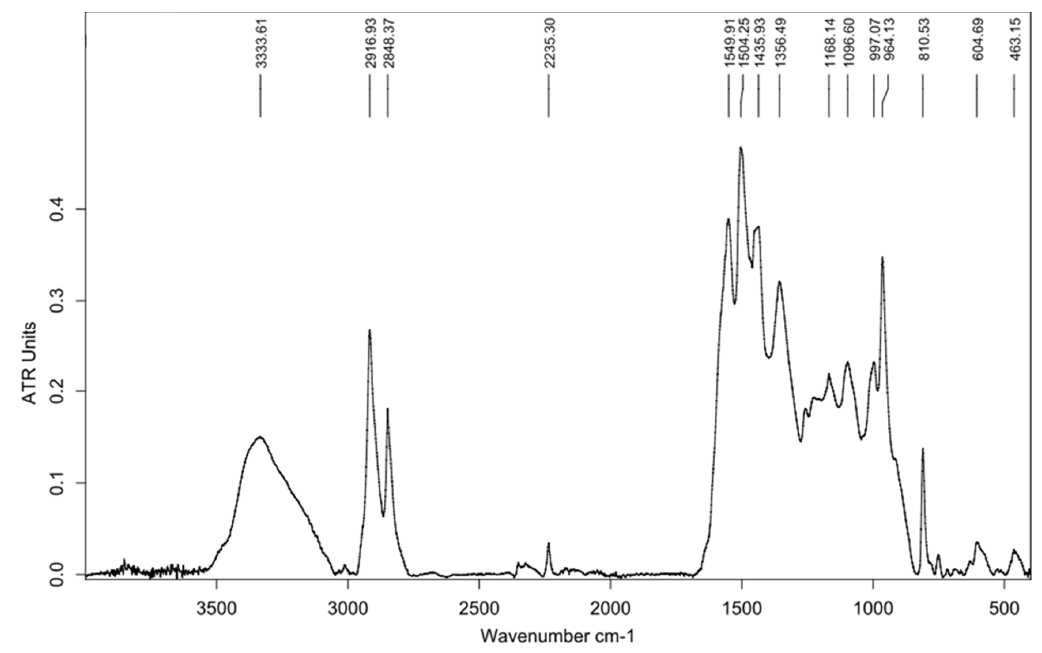
Figure 8. IR spectral analysis of the chemical composition of the matrix of the hybrid composite.